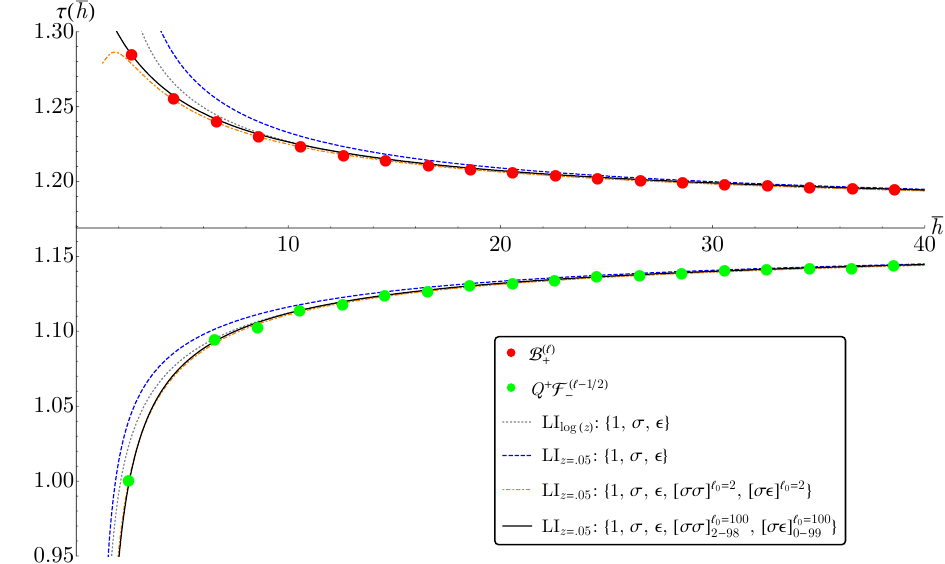
Figure 4 . Leading twist trajectories in the B ( ‘ ) and F ( ‘ ) sectors from the extremal functional + − method compared with analytic predictions from the Lorentzian inversion formula after inputting t - channel exchange of various sets of operators. The shown extremal spectrum was computed at Λ = 51 by minimizing the OPE coefficient λ σσ(cid:15) at the point { ∆ σ , ∆ σ 0 } = { 0 . 5844353559 , 2 . 888214659 } . The horizontal axis is located at τ = 2∆ σ